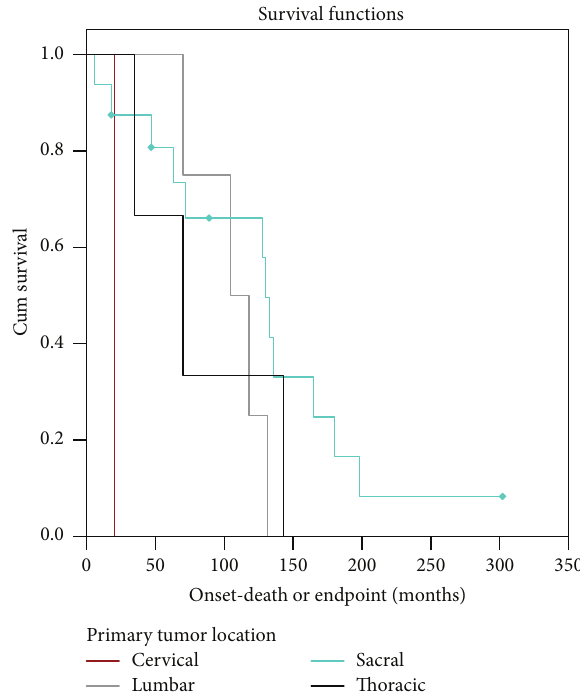
Figure 2: Survival distribution stratified by primary tumor location. Diamonds represent censored data